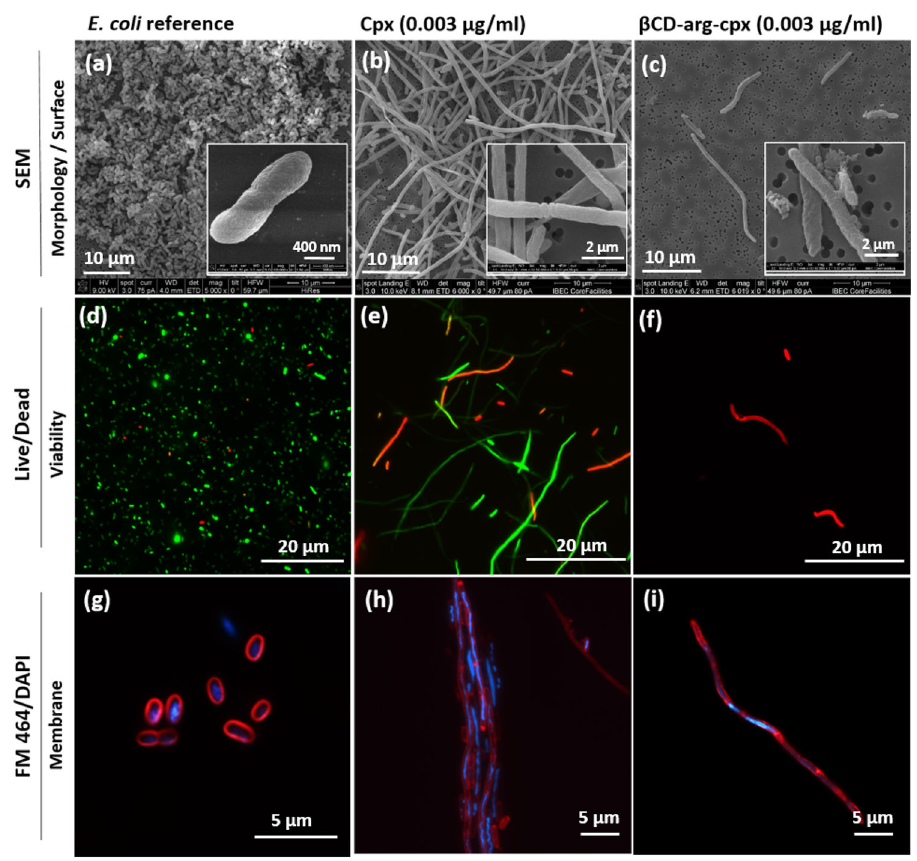
Fig. 7 E. coli MG1655 exposed to cipro fl oxacin and the β CD-arg-cpx complex. Morphology and surface of E. coli cells before ( a ) and after exposure to low cpx concentration (0.003 μ g/ml or 0.008 μ M) ( b ) and equivalent of cpx in β CD-arg-cpx (0.003 μ g/ml or 0.002 μ M) ( c ); Live E. coli stained with a Live/Dead dyes ( d ) and fraction of viable E. coli cells treated with 0.003 μ g/ml (0.008 μ M) cpx ( e ) and β CD-arg-cpx (0.002 μ M) ( f ). Membrane structure of wild-type E. coli stained with FM464/DAPI dyes ( g ) and bacteria treated with 0.003 μ g/ml pure cpx (0.008 μ M) ( h ) and CD-arg-cpx complex (0.002 μ M) ( i